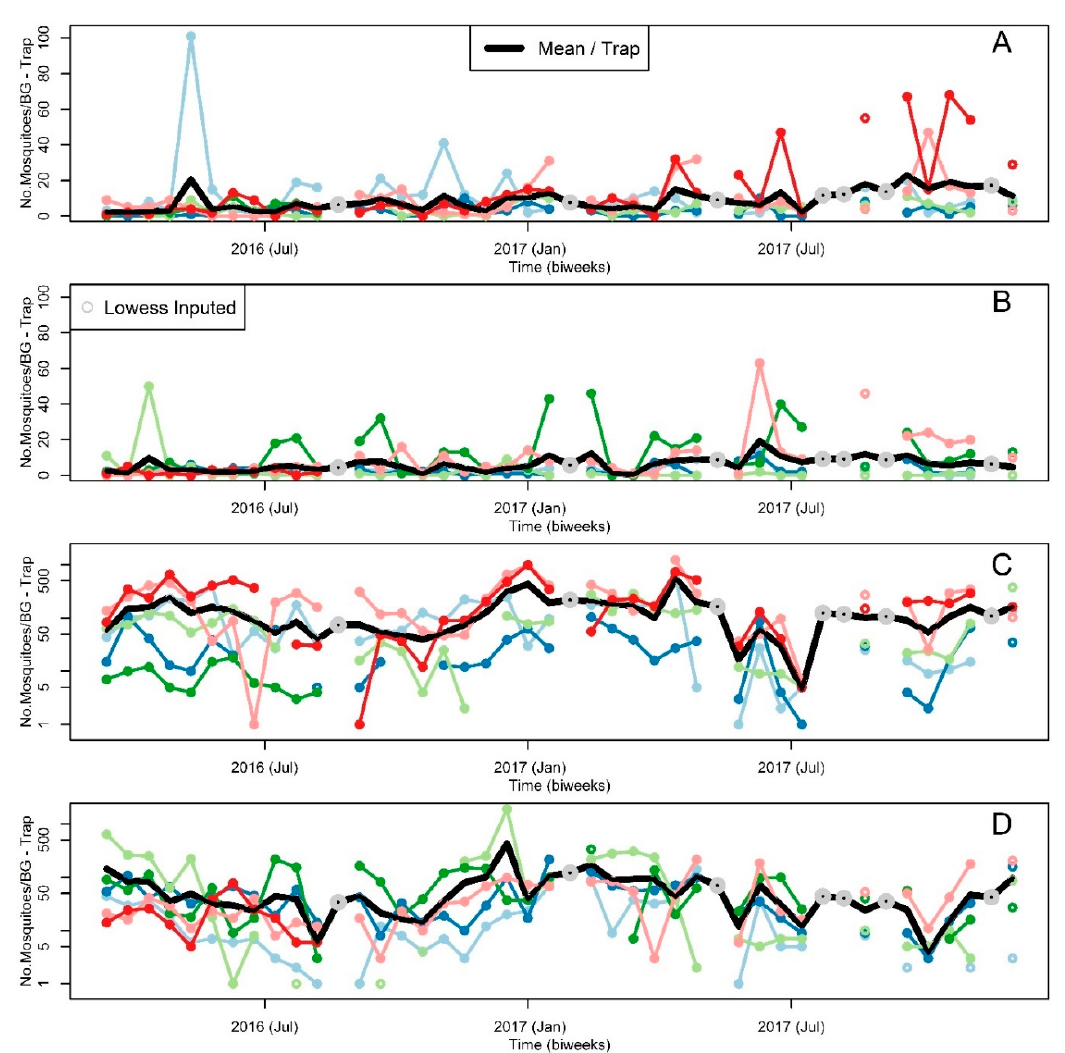
Figure 3. Mosquito Abundance Time Series. Aedes aegypti per BG Sentinel trap collection in ( A ) Sanmin and ( B ) Nanzih. Culex quinquefasciatus per BG Sentinel trap collection in ( C ) Sanmin and ( D ) Nanzih. At each site line colors correspond to the trap locations in Figure 1, with the exception of black lines which represent average values, see inset legend in ( A ). Grey circles indicate abundance estimates interpolated with lowess, see inset legend in ( B ). To ease visualization the y axis in ( C , D ) is shown in logarithmic scale.